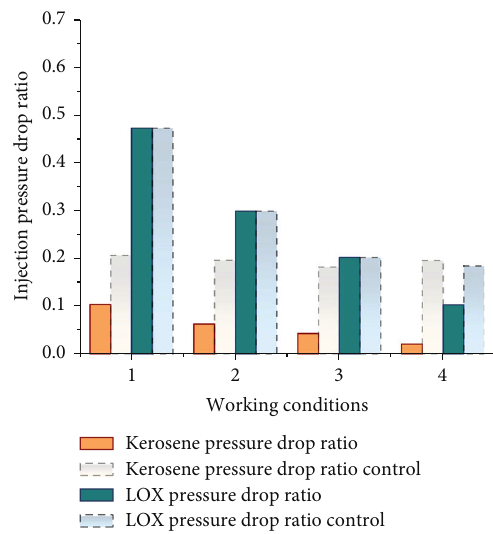
Figure 19: Injection pressure drop ratio of the thrust